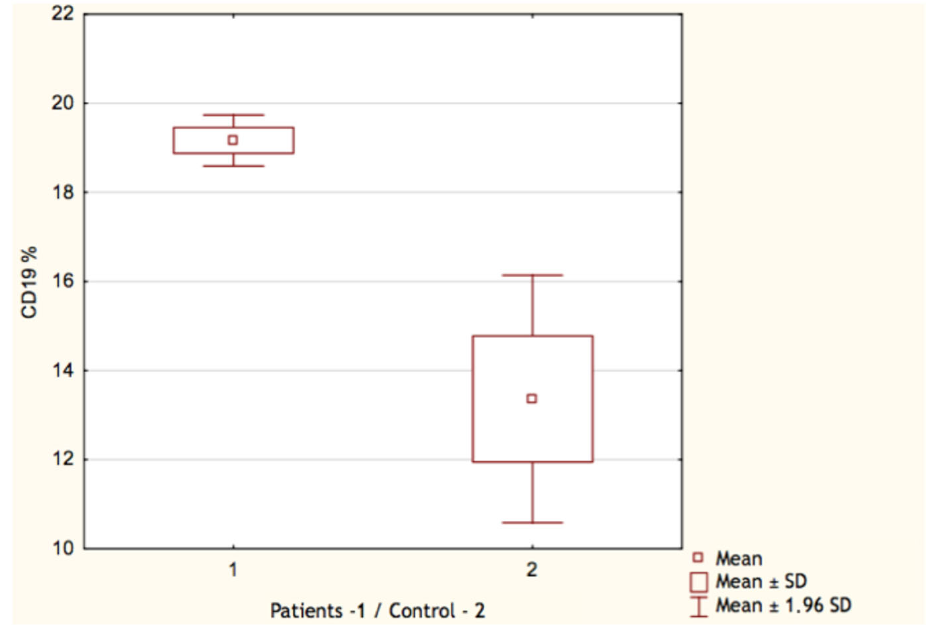
Figure 1. Percentage of CD19+ lymphocytes in patients (1) and control group (2).